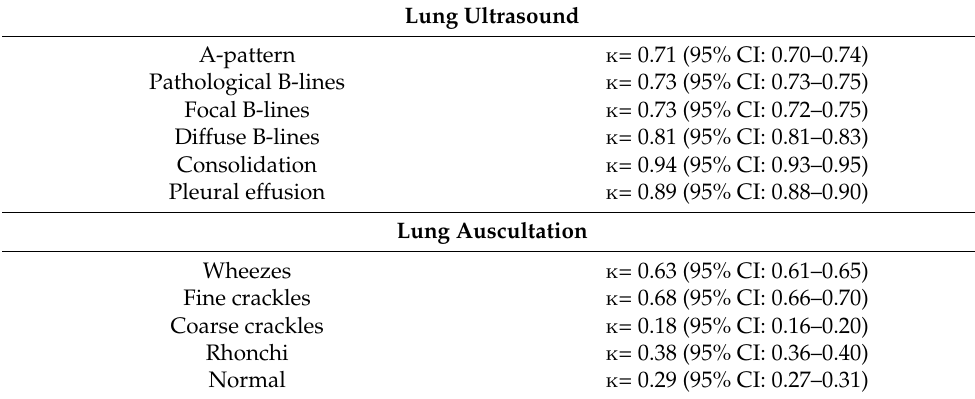
Table 3. Interobserver